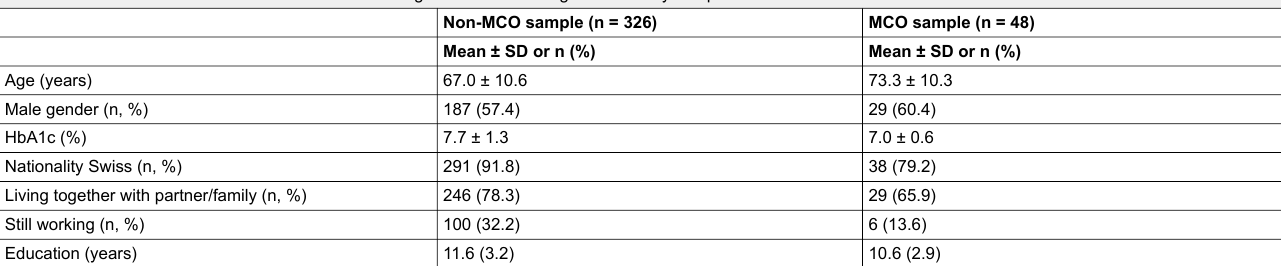
Table 1: Patient characteristics between the non-managed care and managed care study samples. Non-MCO sample (n =